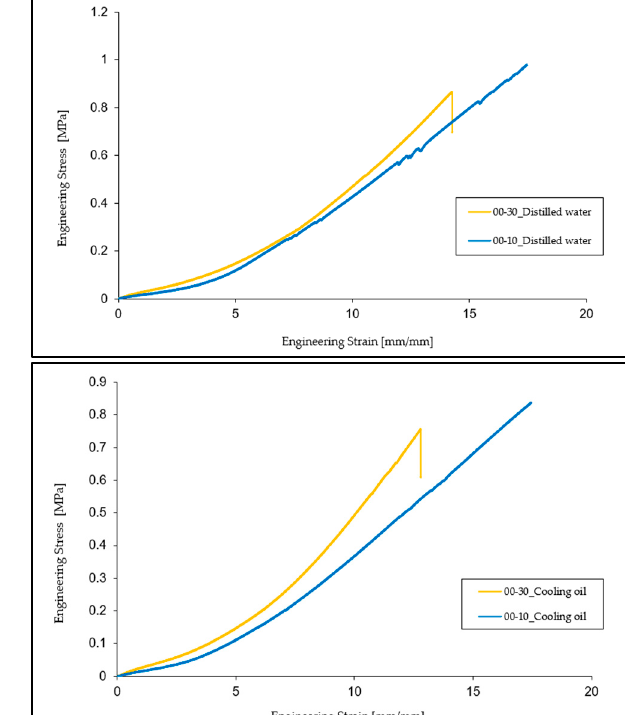
Figure 9. Comparative average of specimens 00-30 and 00-10 at UV.